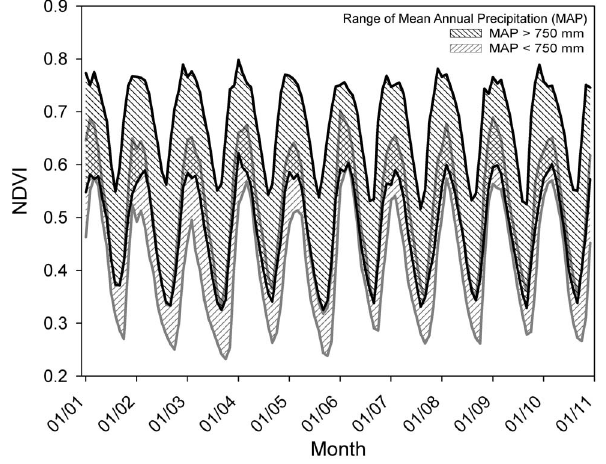
Figure 2. Variability of observed NDVI for the study region for two mean annual precipitation (MAP) ranges.